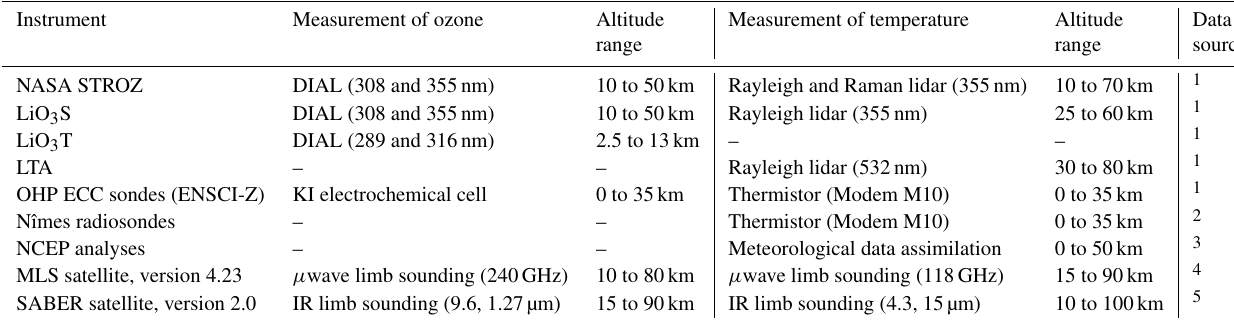
Nîmes radiosondes – NCEP